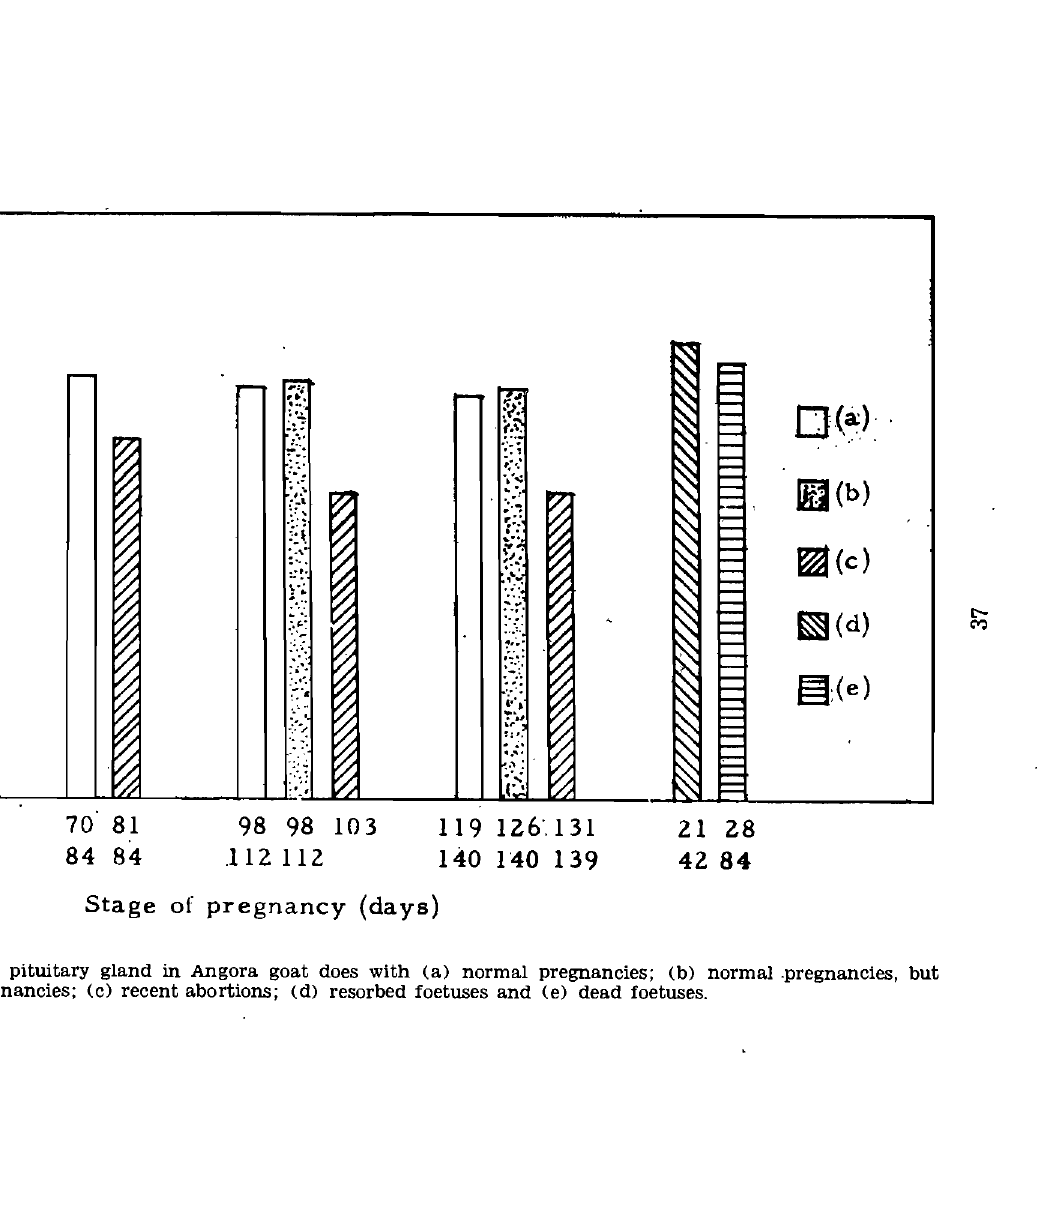
Fig. 1. Luteinising hormone activity of the anterior pituitary gland in Angora goat does with (a) normal pregnancies; (b) normal .pregnancies, but abortion during previous pregnancies; (c) recent abortions; (d) resorbed foetuses and (e) dead foetuses.